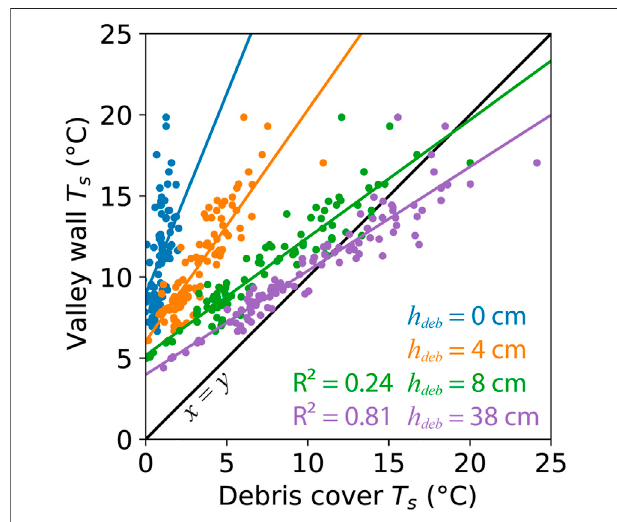
FIGURE 3 | Thermal camera derived surface temperatures over the observation period shown in Figure 5 . Debris cover surface temperatures approach the warm valley wall temperature as debris thickness increases. Where debris is suf fi ciently thick, it is possible surface temperature from these two surfaces could be used interchangeably to force a model of local sub-debris melt, giving preference to whichever is easier to collect in a given fi eldsetting.Modelcoef fi cientsshouldbeabletoaccommodateanyvalleywall aspect. Imaging rock surfaces, preferably till, rather than vegetation is likely critical to maintain a similar emissivity. These data suggest an off-plot, non- zero convergence, likely due to differences in emissivity/aspect/surface angle, or the temperature at the surface of a 38 cm debris cover may not be entirely free from close proximity temperature modulation from glacier ice